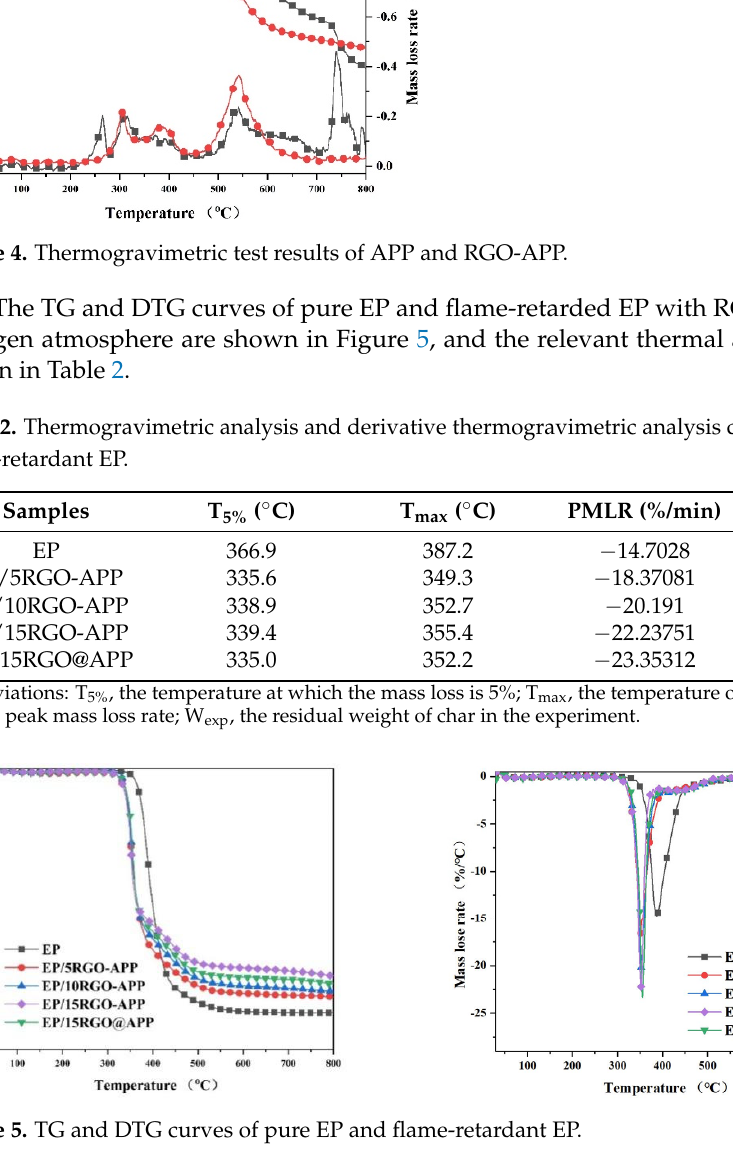
Figure 3. SEM images and EDS maps of APP and RGO-APP and element distribution of RGO-APP: (a) Carbon element, (b) Nitrogen element, (c) Oxygen element, (d) Phosphorus element.